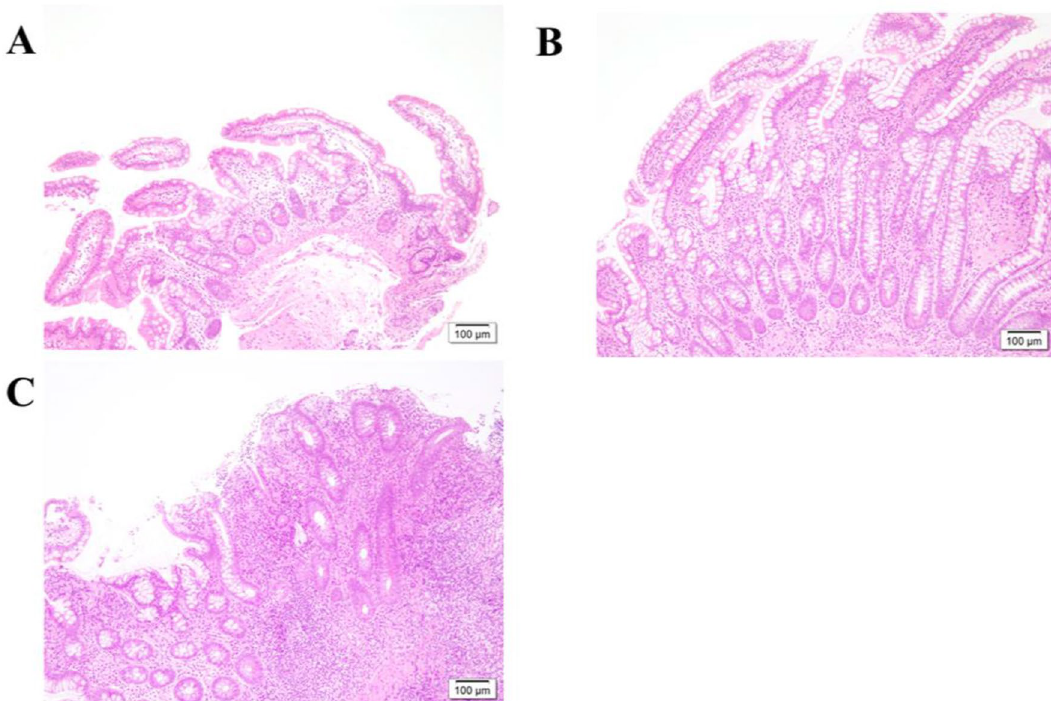
Figure 1. Typical cases of AL, PP and DP. 32 years-old, male, 1.3 years after the pouch usage. cPDAI = 0 (no symptoms). ( A ) AL, ePDAI = 0, hPDAI = 0, CMS = 1, SIBD = 2, Goblet cell rate = 14. ( B ) PP, ePDAI = 2, hPDAI = 2, CMS = 3, SIBD = 4, Goblet cell rate = 23. ( C ) DP, ePDAI = 2, hPDAI = 3, CMS = 4, SIBD = 4, Goblet cell rate = 35. hPDAI-pouchitis disease activity index histology subscore; CMS-colonic metaplasia scores; SIBD-the IBD score.